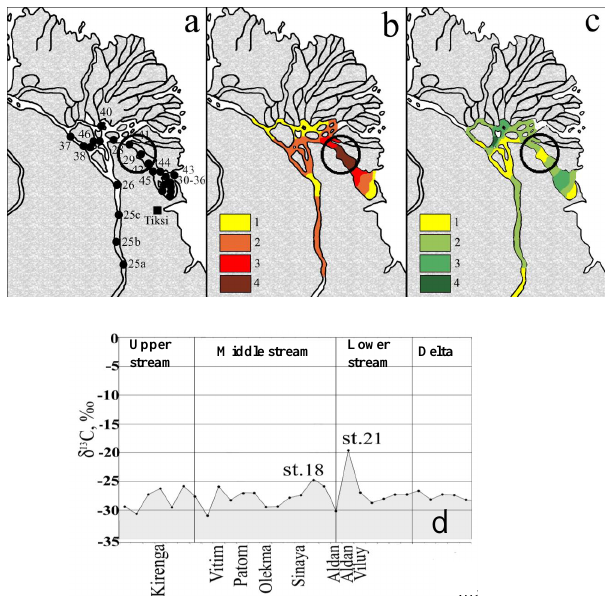
Fig. 2. (a) Distribution of sampling sites in the lower Lena River- Lena delta channels in late July–early August 2003; (b) PM distri- bution in the surface layer, mgl − 1 : (1) < 10, (2) 11–20, (3) 21–30, (4) > 30; (c) POC distribution in the surface layer, mgl − 1 : (1) < 1, (2) 1–1.3, (3) 1.4–1.6, (4) > 1.6; (d) distribution of particulate or- ganic carbon isotope ratios ( δ 13 C) in the surface layer of the Lena River: from the upper stream to the